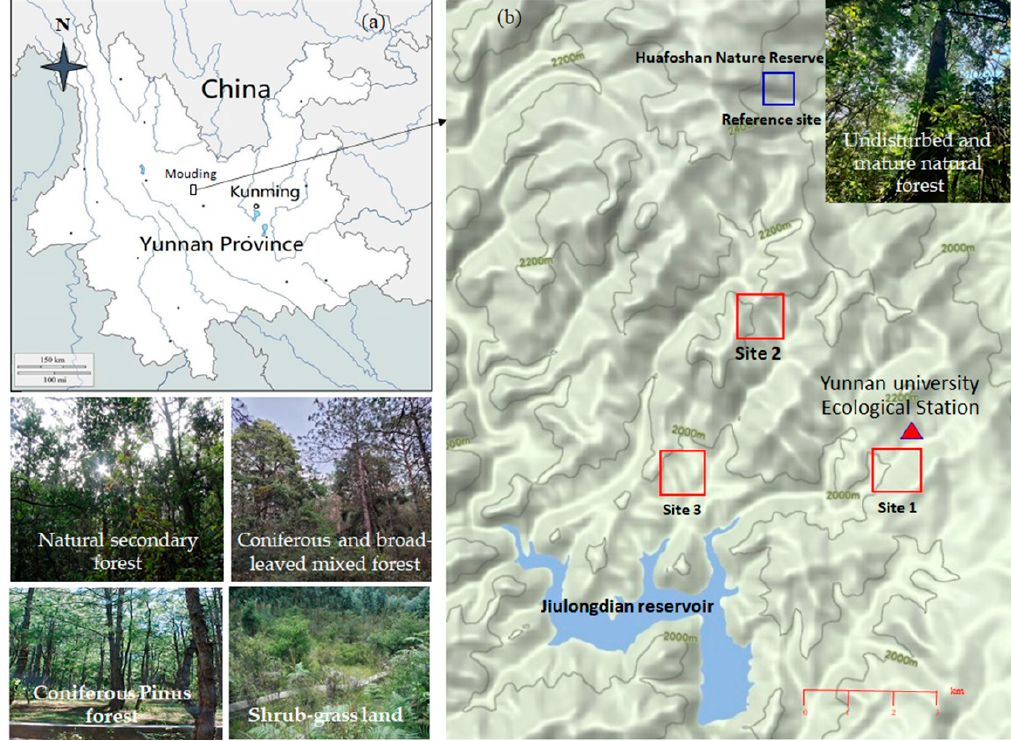
Figure 1. Localization of the study area ( a ) and sampling sites ( b ) in Yunnan, southwest China.